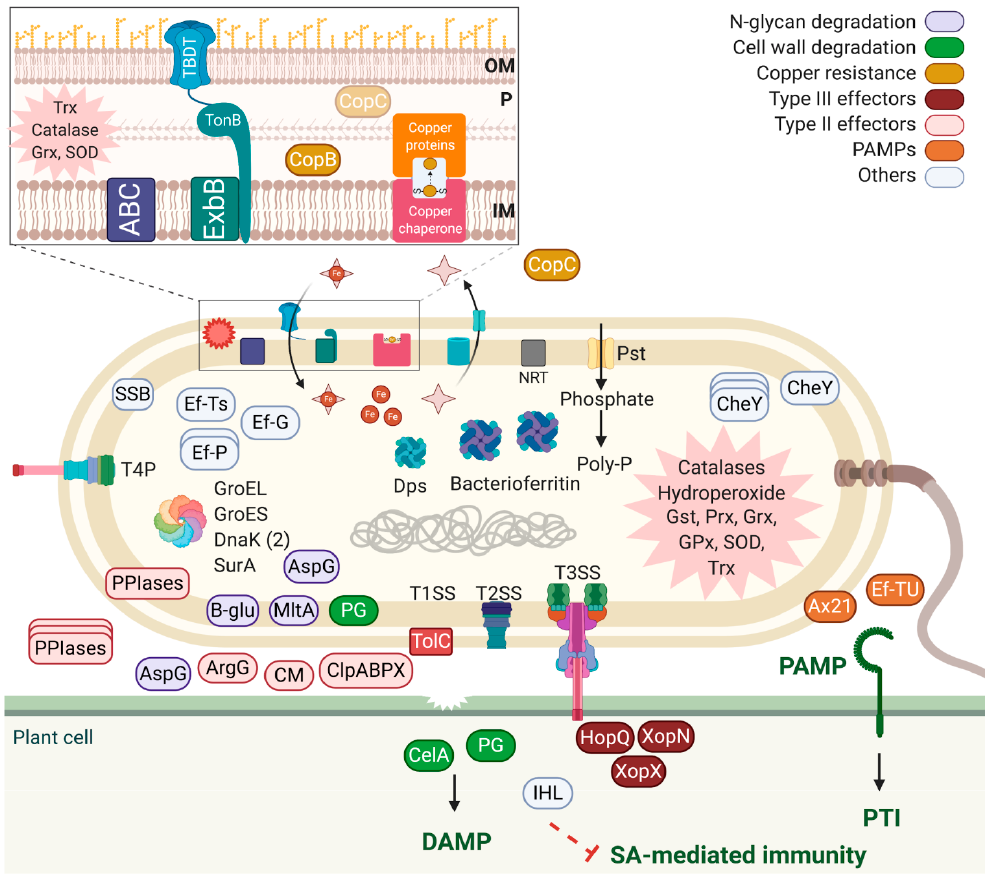
Figure 7. Role of Xaj 417 proteins in disease development. OM: outer membrane, IM: inner membrane,